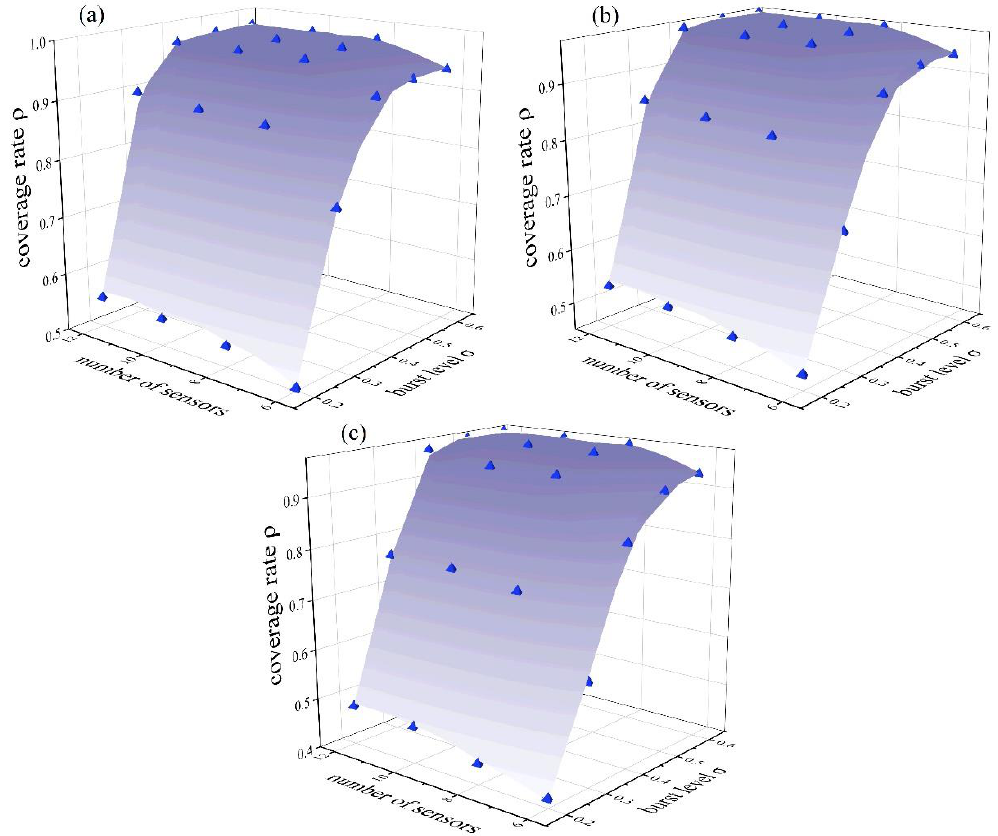
Figure 10. Coverage rate of pressure sensors under different operating conditions. ( a – c ) represent the coverage rates at average flow, maximum flow and minimum flow, respectively.